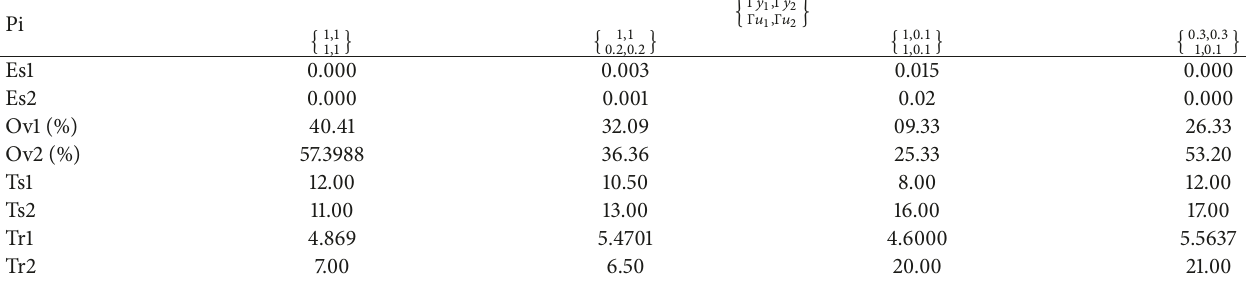
Table 1: Weight parameter Γ 𝑖 dependence of transient